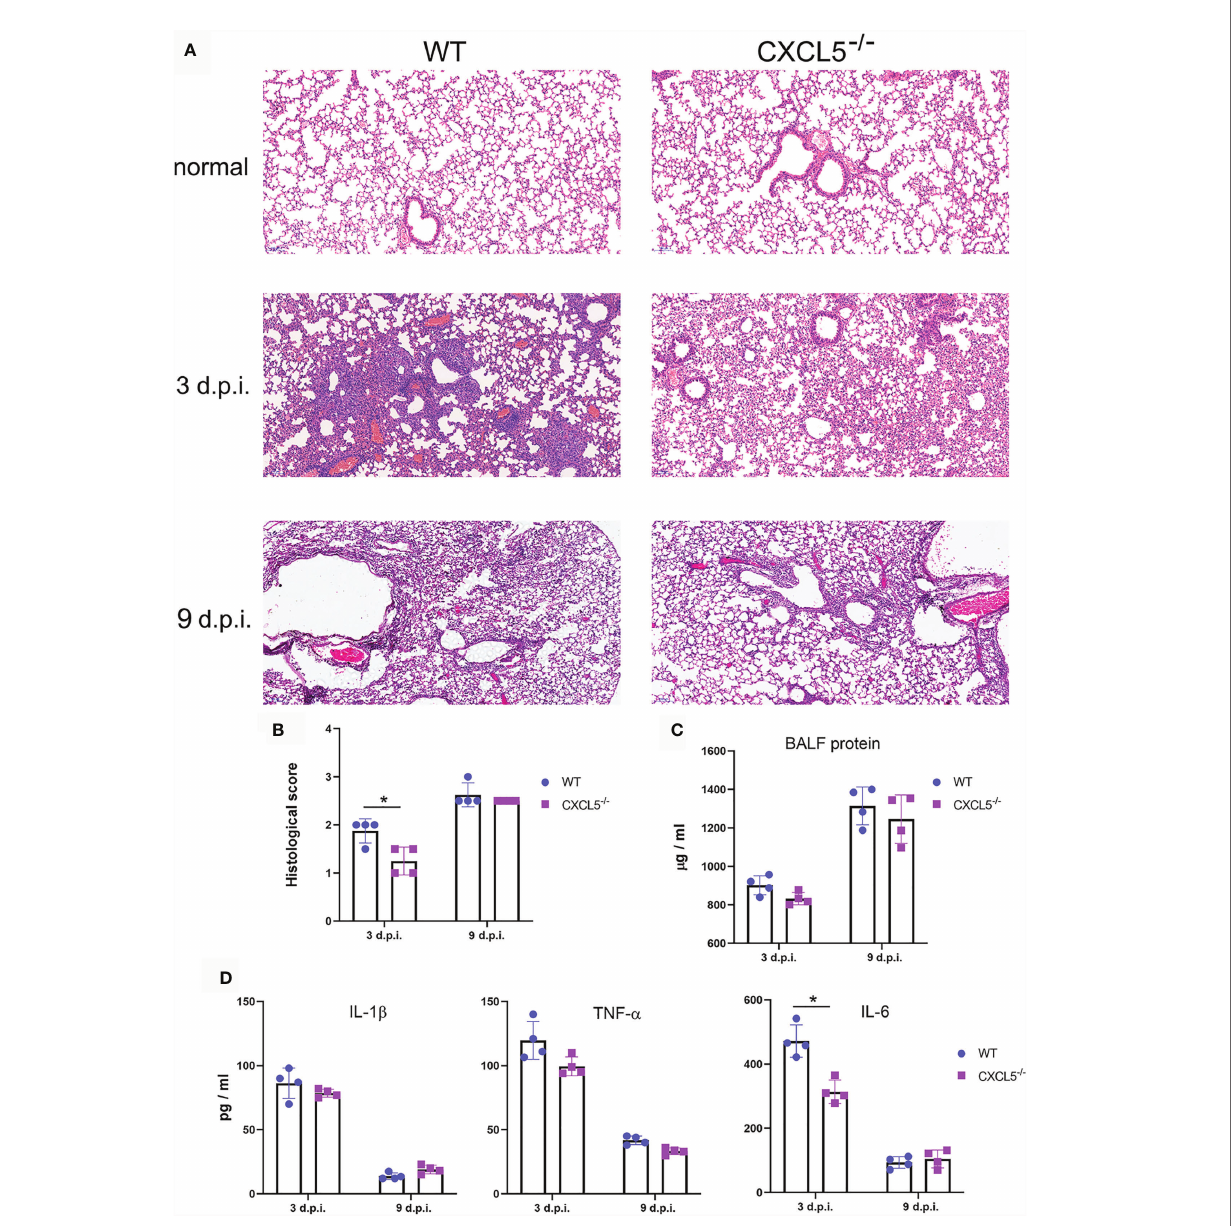
FIGURE 2 | Comparison of lung pathology and in fl ammation between WT and CXCL5 -/- infected mice. (A) Histopathology of H&E – stained lung sections from WT and CXCL5 -/- mice 3 and 9 d.p.i. (B) Lung histological scores were assessed for 4 mice in each group by a blinded veterinary pathologist as described in the MATERIALS AND METHODS section. (C) The total protein concentrations in the BALF of infected mouse lungs were determined at 3 and 9 d.p.i. (D) The levels of the in fl ammatory cytokines TNF-a, IL-1 b , and IL-6 were measured by ELISA. The error bars represent the SDs of 4 samples. *P < 0.05 based on Student ’ s t